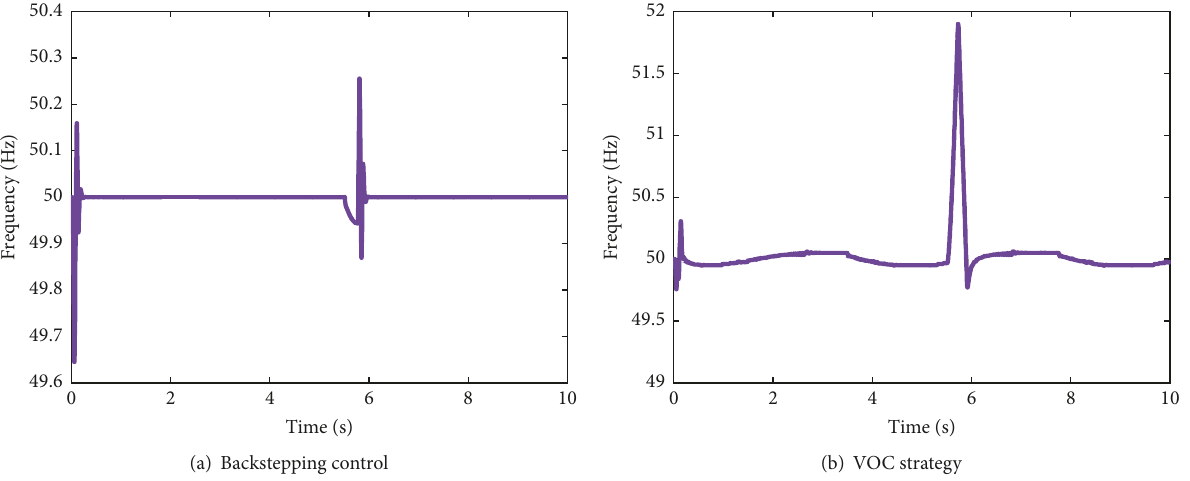
Figure 18: Frequency response of the VS-WFS under grid faults.